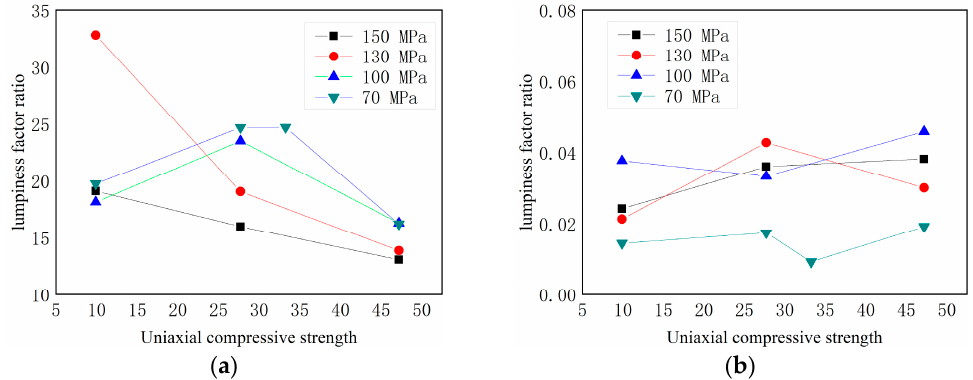
Figure 12. Relationship between lumpiness factor ratio and uniaxial compressive strength. ( a ) Lumpiness factor for large blocks. ( b ) Lumpiness factor for small blocks. ness factor for large blocks. ( b ) Lumpiness factor for small